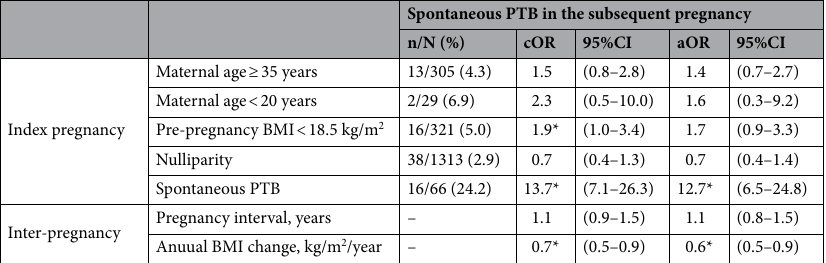
Spontaneous PTB in the subsequent